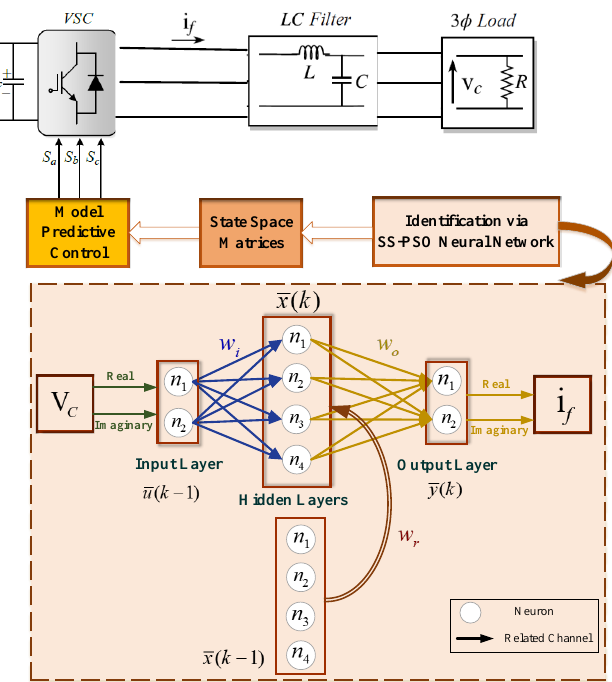
Figure 2. Proposed architecture.